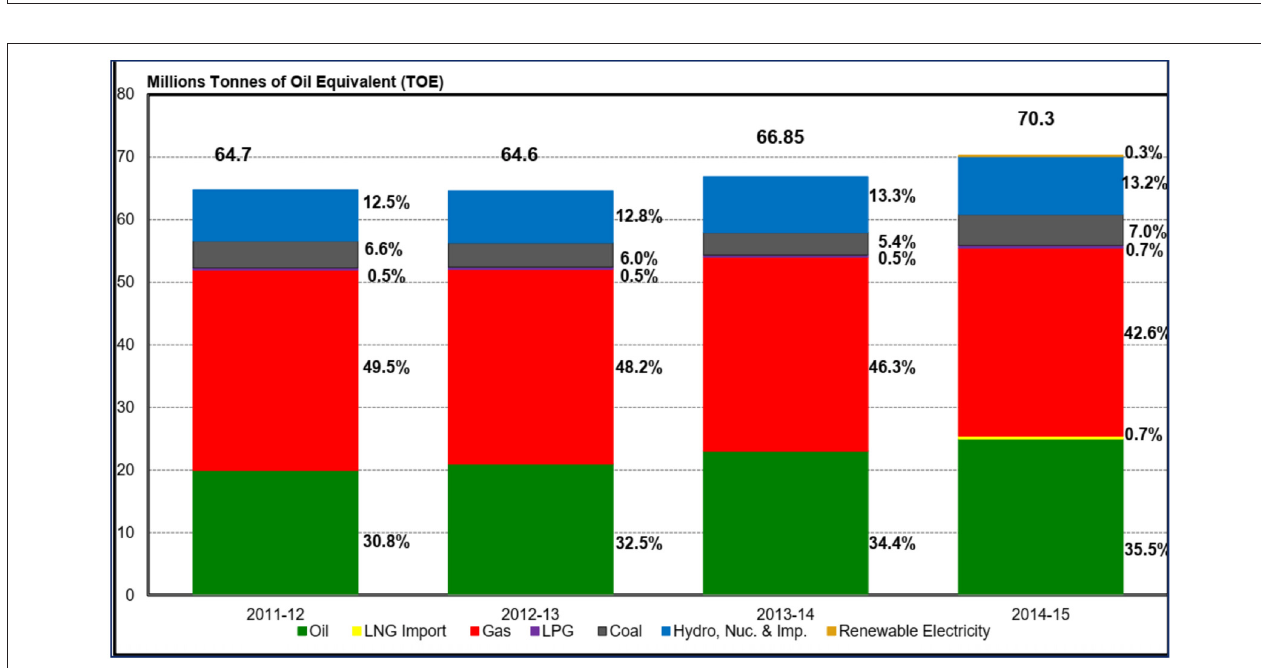
FIGURE 4 | Primary energy supplies by source 4